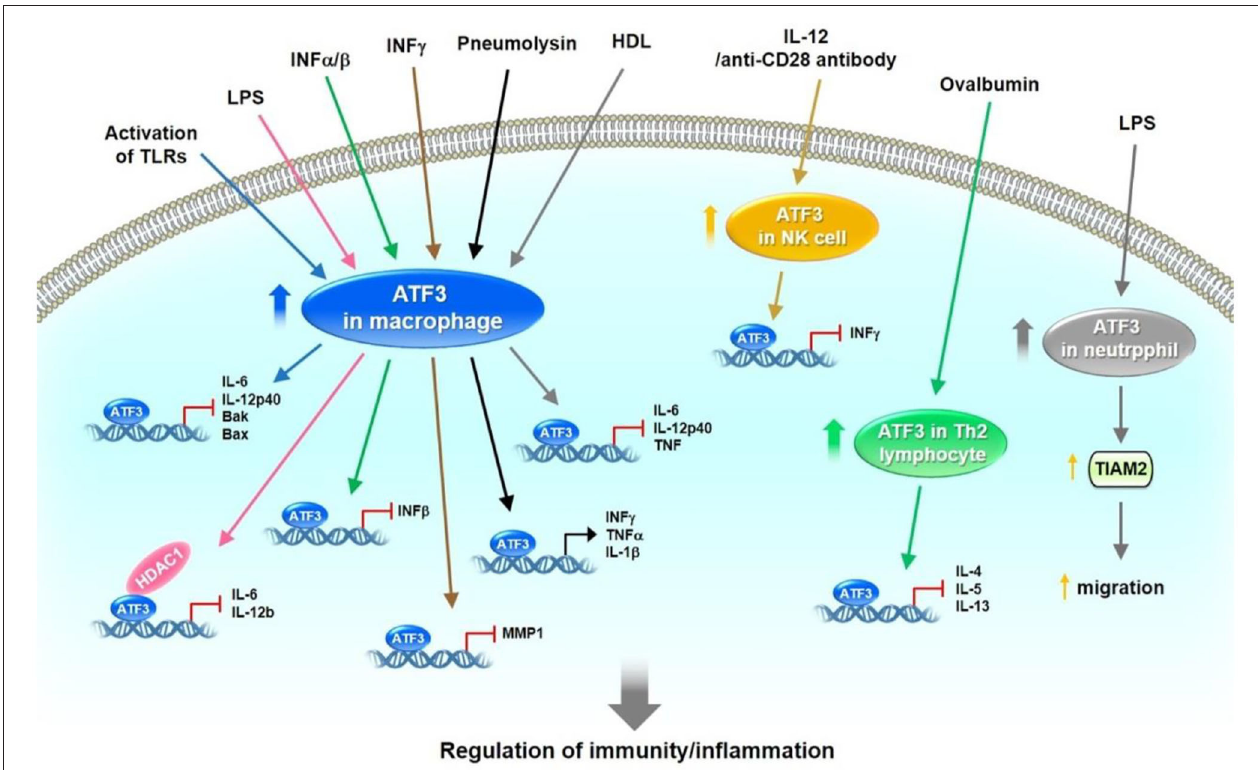
FIGURE 3 | The role of ATF3 in host defense by the regulation of immune responses. In immune cells, such as macrophages, NK, Th2 lymphocyte and neutrophil cells, ATF3 is expressed at low levels. After activation of these immune cells by different signaling pathways initiated by TLRs, LPS, IFN α / β / γ , pneumolysin, IL-12, anti-CD28 antibody and ovalbumin, ATF3 was upregulated. Subsequently, ATF3 downregulates the expression of target genes, including cytokines (IL-1 β , IL-4, IL-5, IL-6, IL-12p40, IL-12b, IL-13, TNF, IFN β / γ ) and pro-apoptotic gene (Bak and Bax) by binding to the promoters. In addition, ATF3 enhanced neutrophil chemotaxis via TIAM2 expression Collectively, these observations demonstrate that ATF3 plays an important role in regulating immune responses and maintaining normal host